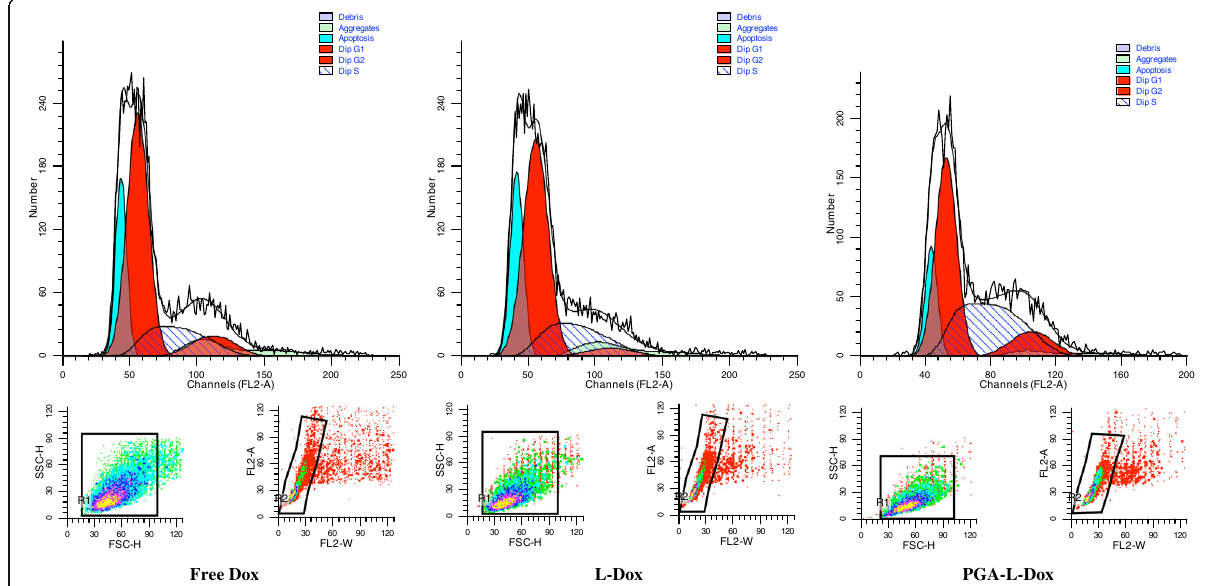
Fig. 5 The cell cycle analysis of HepG2 cells via Flow cytometry after 48 h treatment with free Dox, L-Dox, and PGA-L-Dox (containing Dox concentrations of 10 μ